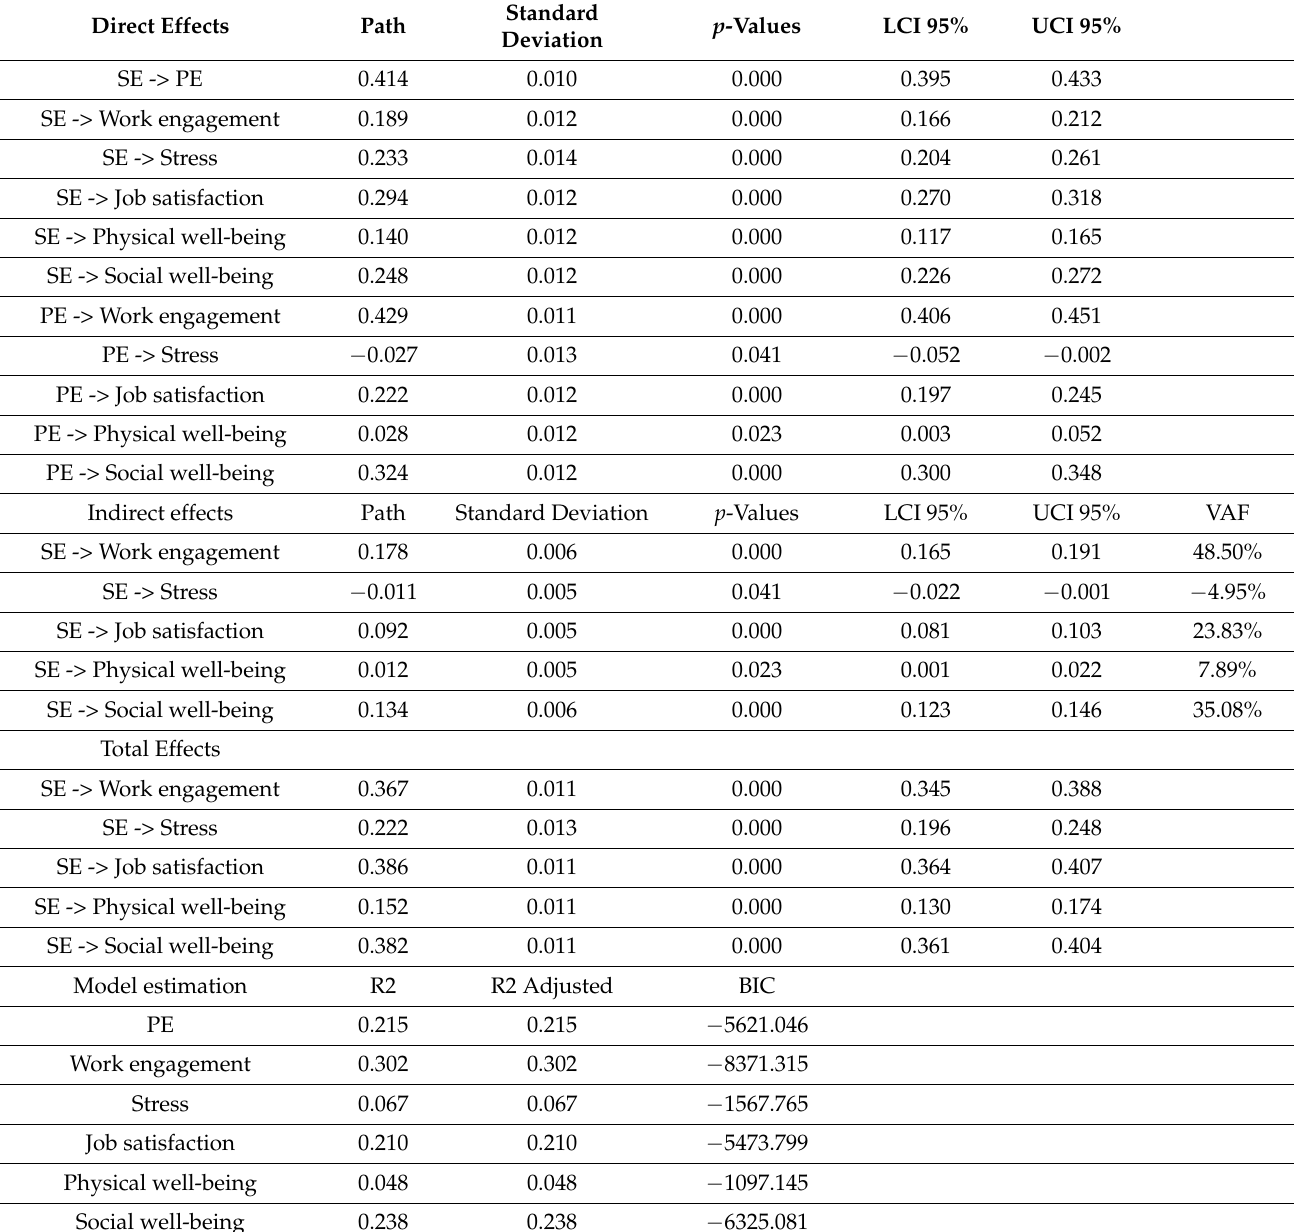
Table 3. Summary of mediating effect